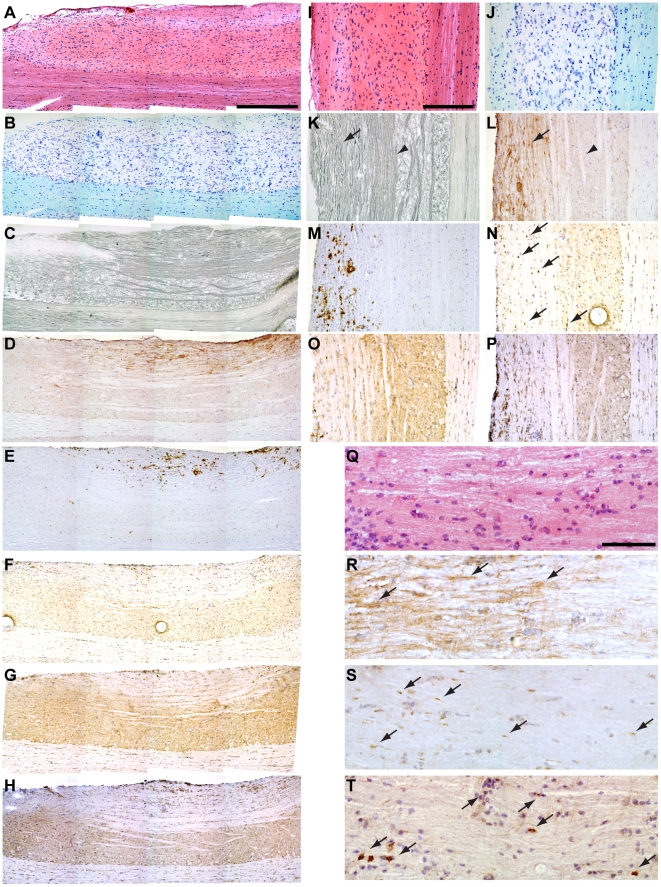
MHC class I is expressed in demyelinated lesions.MHC class I expression is localized to sites of demyelination, axon injury, and CD8+ T cell infiltration. (A–C, I–K, Q) Histology of spinal cord at 90 dpi revealed cellular infiltrate by H&E (A, I, Q), loss of Luxol fast blue stained myelin (B, J), and dysmorphic Bielschowsky-stained axons (C, K). (D–H, L–P, R–T) Immunostaining further revealed MHC class I expression on fibers in the demyelinated lesion (D, L, R), MHC class II staining on cells in the demyelinated lesion (E, M), and the presence of CD8+ (F, N, T), CD4+ (G, O), and CD11b+ (H, P) immune cells within the demyelinated lesion. (S) The axon injury marker APP was also observed on structures within demyelinated lesions containing MHC class and CD8+ cells. Scale bar in (A) is 500 µm and refers to (A–H). Scale bar in (I) is 250 µm and refers to (I–P). Scale bar in (Q) is 50 µm and refers to (Q–T).